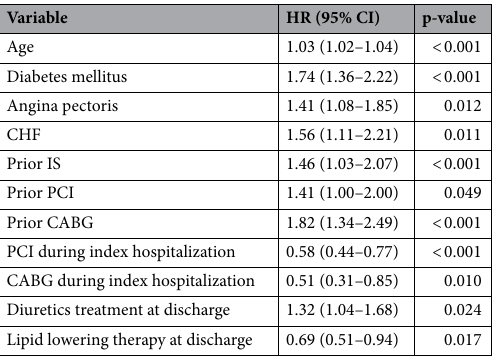
Table 7. Risk factors associated with CV-death, MI and IS among 1379 patients discharged after hospitalization for ACS in a multivariable Cox regression analysis. CHF congestive heart failure, IS ischemic stroke, PCI percutaneous coronary intervention, CABG coronary artery bypass